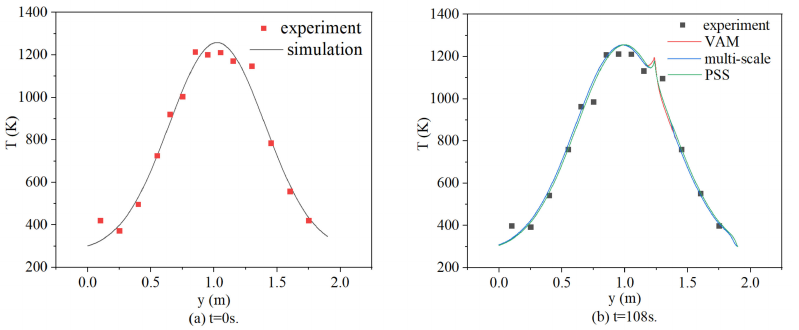
= 0.8% and inlet flow rate of 4